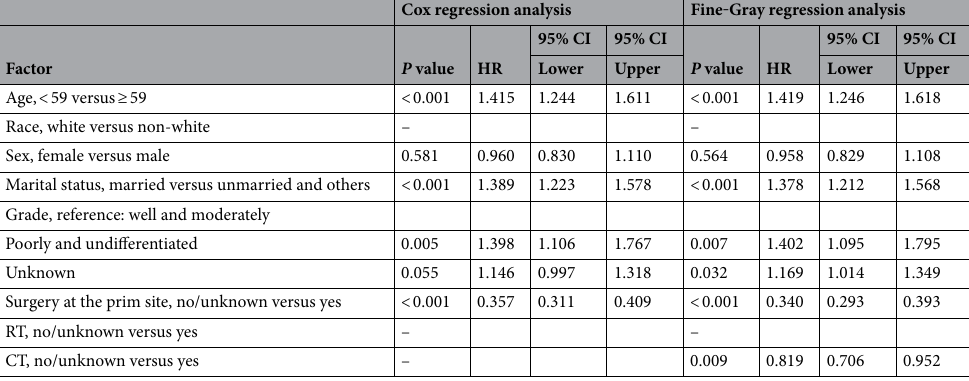
Table 3. Multivariate analysis of OS in stage Ia HCC patients with the Cox regression model and the Fine- Gray regression model. HR, Hazard ratio; CI, confidence interval.